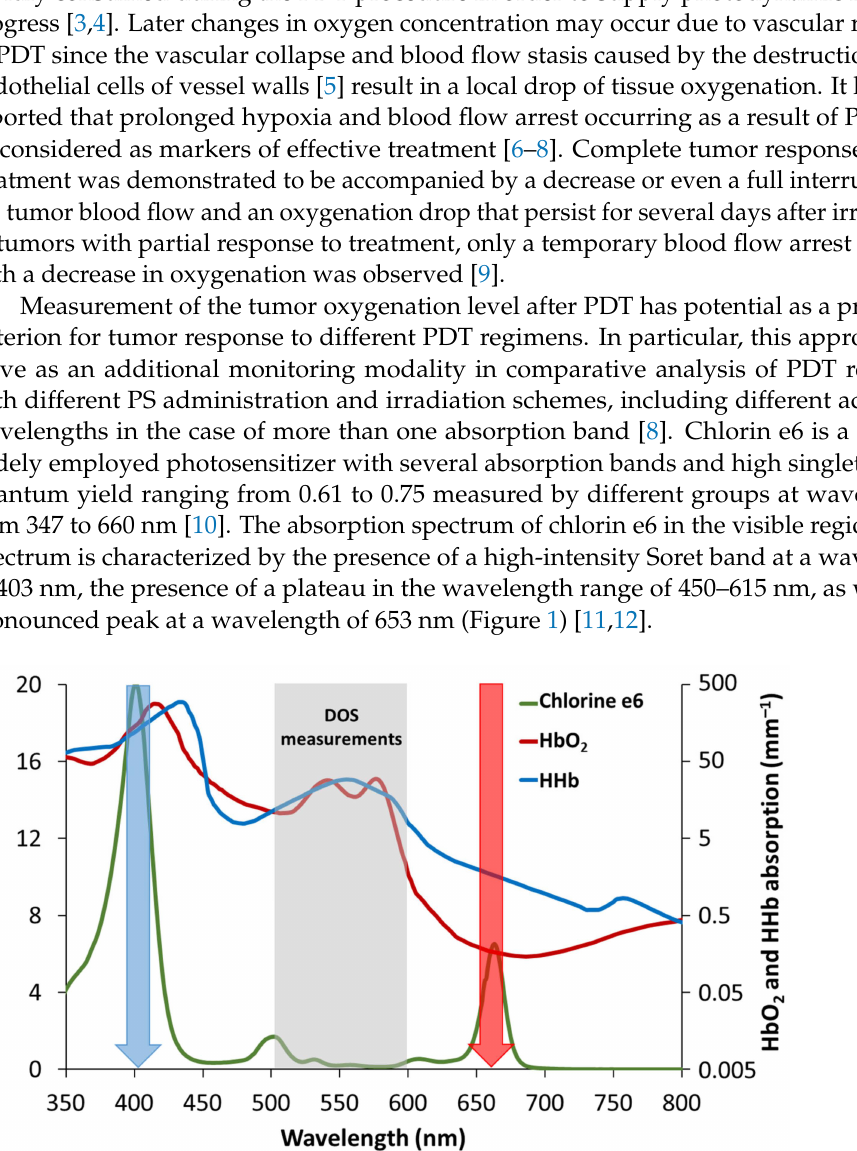
Figure 1. Typical absorption spectra of the chlorin e6 photosensitizer [11,12] and oxy- and deoxy- hemoglobin. Blue and red arrows indicate wavelengths for PDT light irradiation corresponding to local peaks of absorption 403 and 653 nm. High absorption of hemoglobin in the vicinity of 400 nm compared to 660 nm provides lower light penetration depth. The wavelength range for DOS evaluation is marked with grey. It corresponds to strong relative variations in HbO 2 and HHb spectra and rather low chlorine e6